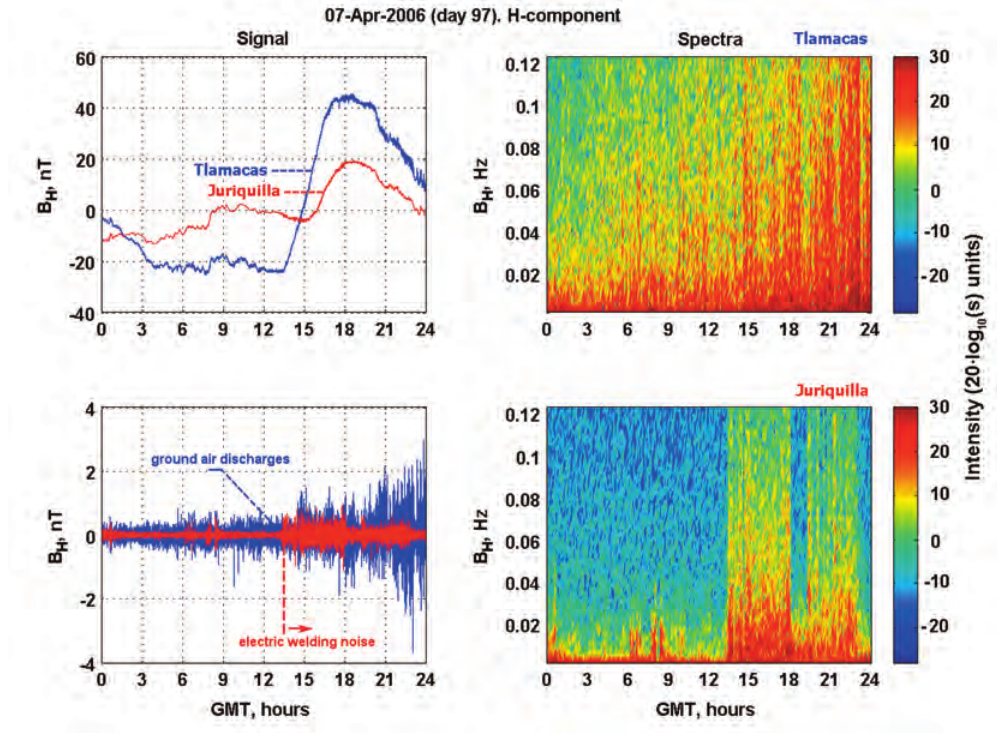
Figure 6. Geomagnetic signals. Left, top, Original signals; Left, bottom, Filtered signals. Blue, Tlamacas station; red, referent Juriquilla station. Right: Spectra measured at Tlamacas (top) and at the referent Juriquilla station (bottom,